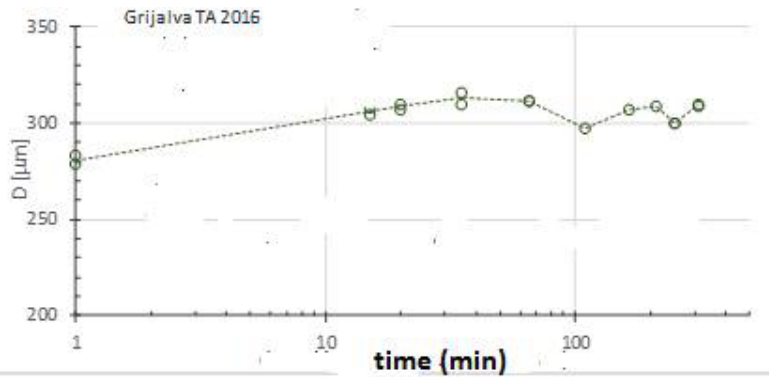
Figure 8. Time evolution of floc diameter in RAF experiments for the Grijalva river. Circles are experimental values and doted line the trend with time.